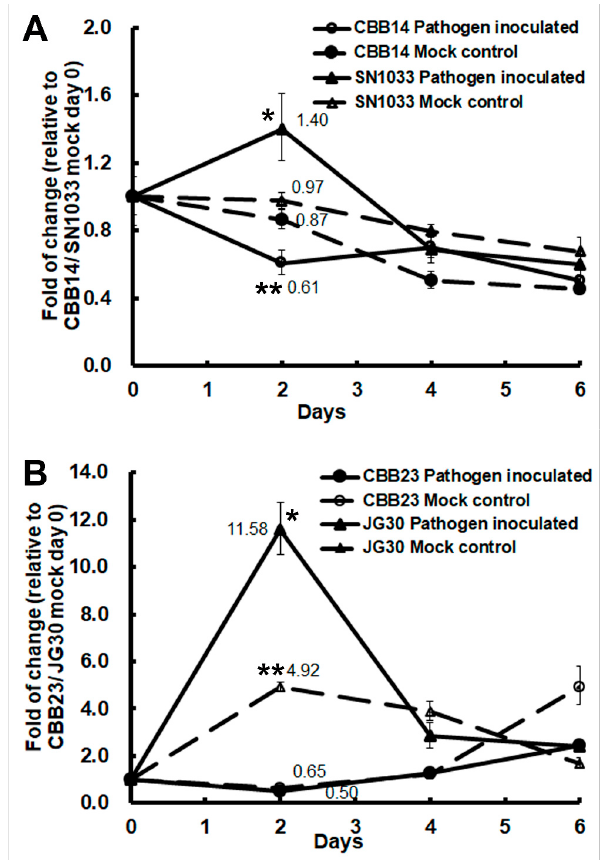
Figure 2. Expression studies of OsFKBP12 in bacterial blight-resistant near-isogenic lines (NILs) and their respective susceptible recurrent parents. ( A ) Expressions of OsFKBP12 in the resistant NIL (CBB14, carrying the Xa14 R locus) and its susceptible recurrent parent (SN1033) of the Japonica variety, upon the challenge with Xanthomonas oryza pv. oryza ( Xoo ) race LN44. ( B ) Expressions of OsFKBP12 in the resistant NIL (CBB23, carrying the Xa23 R locus) and its susceptible recurrent parent (JG30), which is an Indica variety, upon the challenge with Xoo race P6. The 8-week-old plants were inoculated with Xoo (pathogen inoculated) or water (mock control) by a clipping method. Day-0 leaf samples were collected before inoculation. Leaf tissues about 6–8 mm away from the inoculation sites were collected 2 and 4 days after inoculation. Total RNA samples were prepared from the leaf tissues collected, reverse-transcribed, and subjected to real-time PCR. Relative gene expression was calculated by the 2 − ∆∆ CT method [25] and normalized against the expression of the rice actin gene, OsAc1D [26]. Fold-of-change in OsFKBP12 expression in each treatment was compared to the expression on mock control day 0. Folds of change in gene expressions on day 2 are indicated with numerical data. Solid diamond: CBB14 / CBB23-pathogen inoculated; open diamond: CBB14 / CBB23-mock control; solid triangle: SN1033 / JG30-pathogen inoculated; open triangle: SN1033 / JG30-mock control. The statistical significance of the di ff erences between day 2 and day 0 for each treatment of each line were analyzed by one-way ANOVA analysis, followed by LSD as post-hoc test. “*” indicates p < 0.05; “**” indicates p < 0.005. The error bars indicate standard deviation ( n = 3).